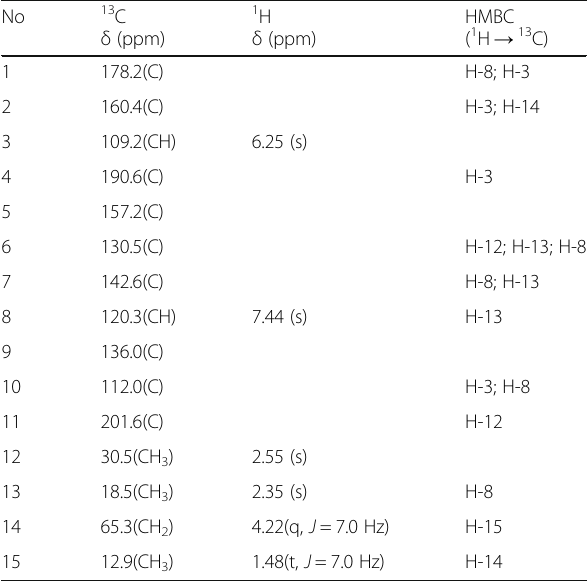
Table 1 1 H and 13 C NMR data of 2-ethoxystypandrone ( 1 )( 1 H 400MHz, 13 C 100MHz in acetone- d 6